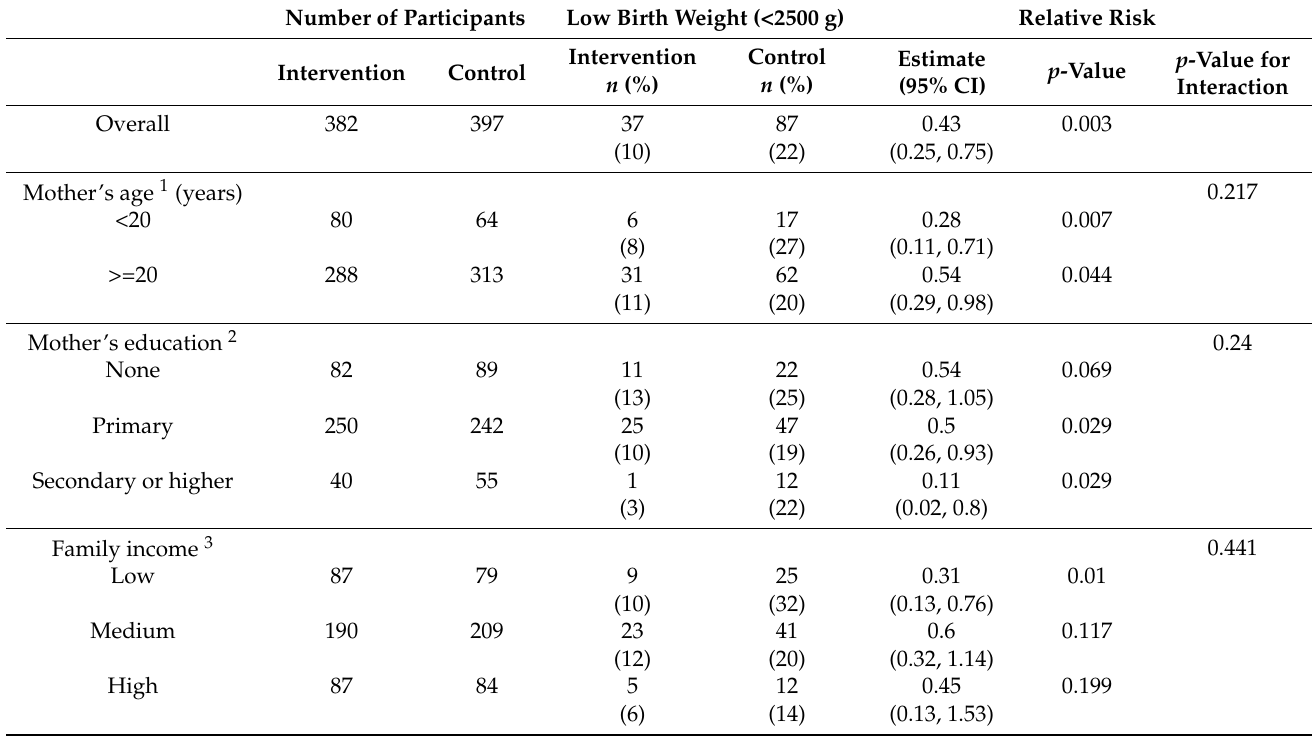
Table 3. Percentage of low birth weight and relative risk of balanced-plate intervention compared to usual